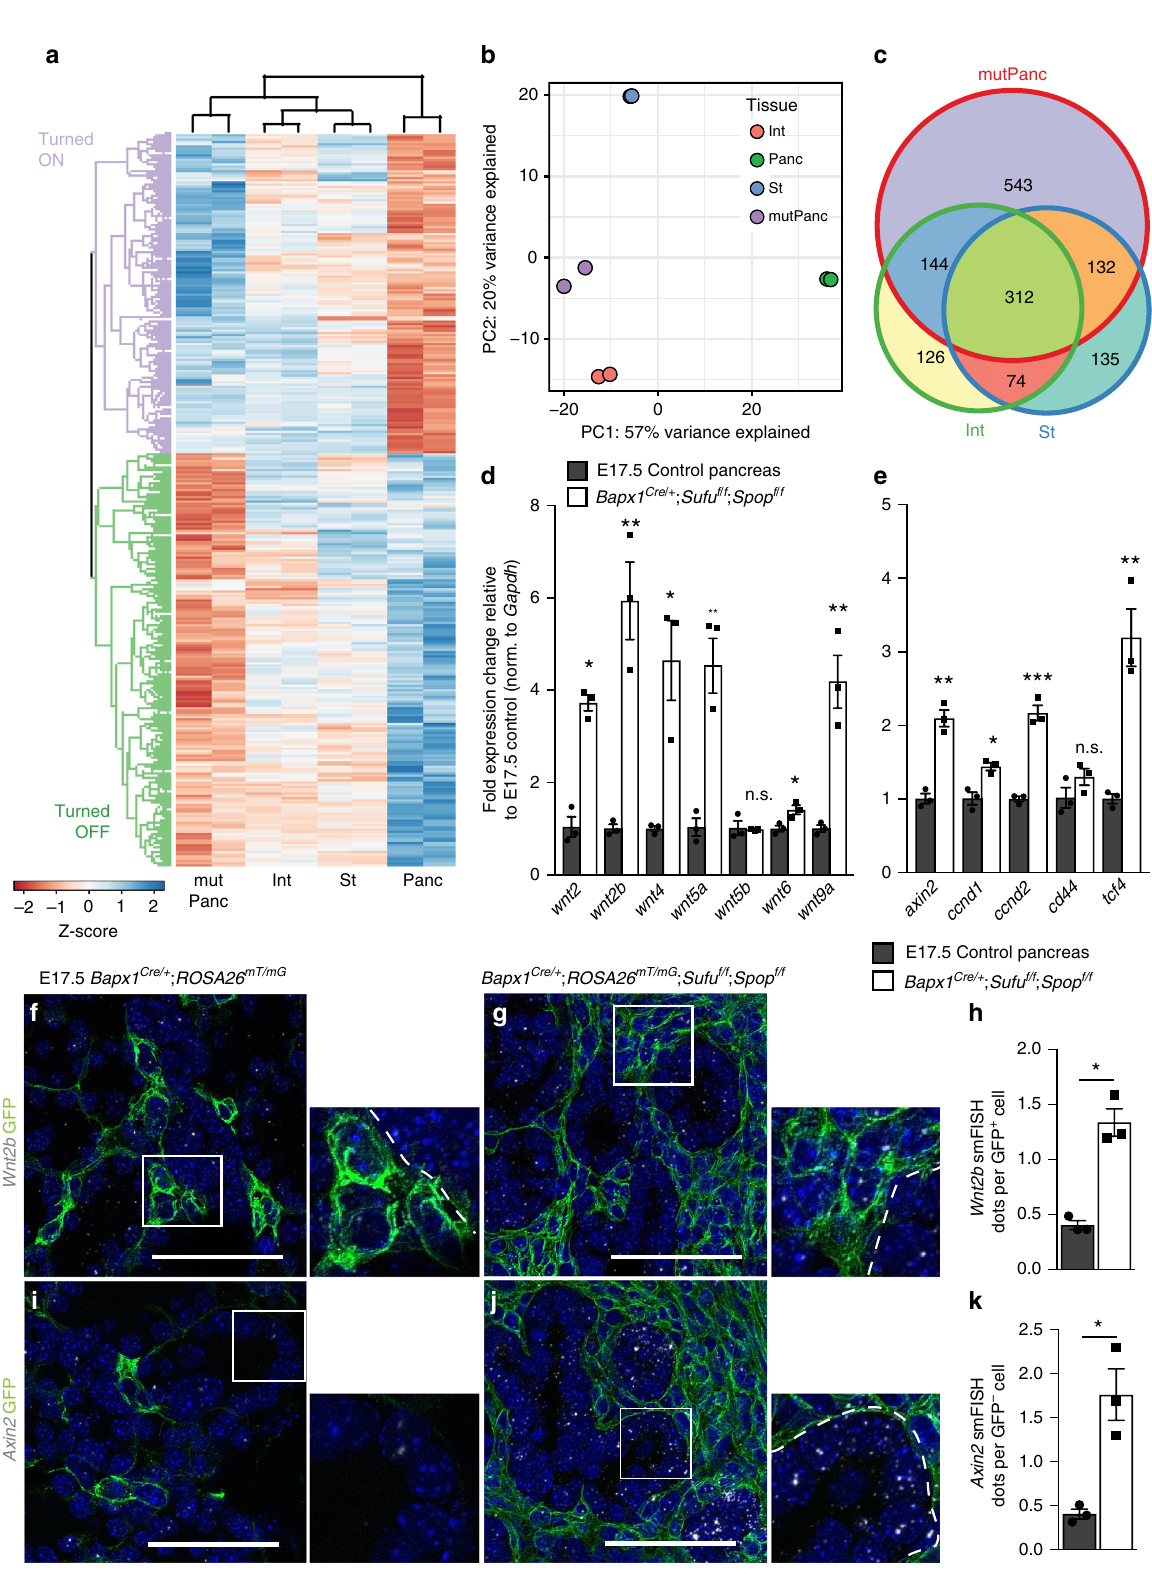
abnormal activation of Wnt signaling induced by Sufu and Spop deletion may contribute to beta cell impairment and suggests Wnt inhibition as a candidate for improving current beta cell differentiation